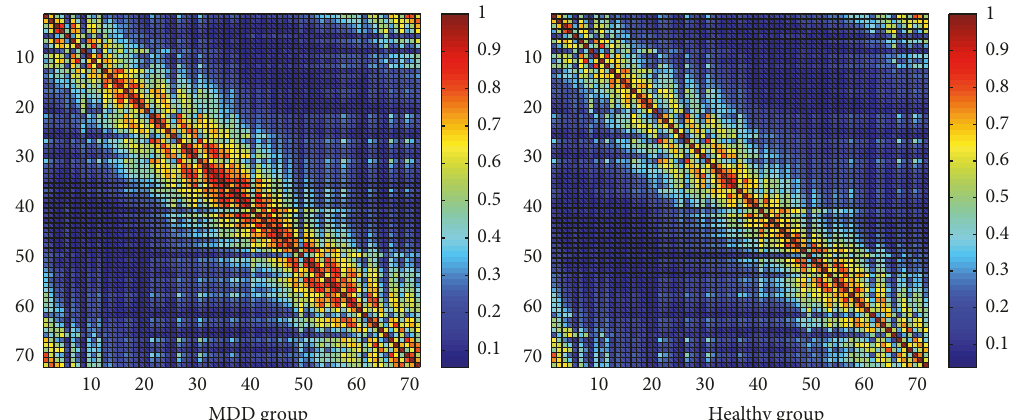
Figure 2: The coherence of MDD group and healthy group in the theta band. The size of the coherence matrix was 72 ∗ 72 . In the matrix map, each chromatic point represented the coherence of two corresponding channels. The horizontal and vertical axes denoted 72 channels.